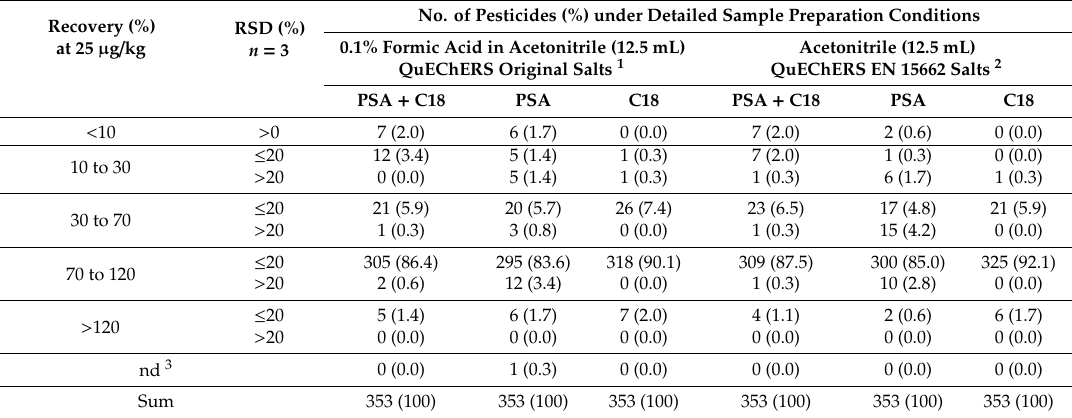
Figure 1. Recovery and partition coefficient (P) [34,35] of 10 representative pesticides that showed a large recovery difference greater than 25% between N = 1 and N = 3. The error bar is the standard deviation of recovery rate ( n = 3). Table 2. Comparison of three dSPE sorbent combinations (PSA + C18, PSA, and C18) at two sample preparation conditions and recovery results for 353 target pesticides. In each preparation, acetonitrile-hexane partitioning ( N = 3) was carried